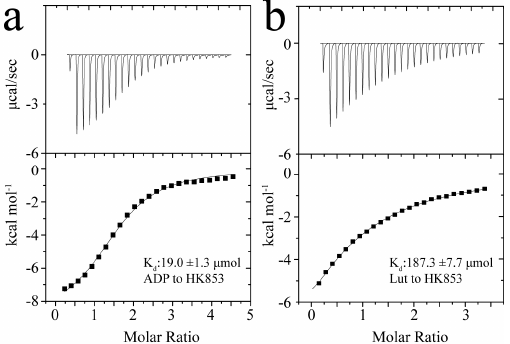
Figure 3. Binding affinities between HK853 cp and ADP/Lut. ( a ) The result of ADP–HK853 cp binding reaction; ( b ) the results of Lut–HK853 cp binding reaction.